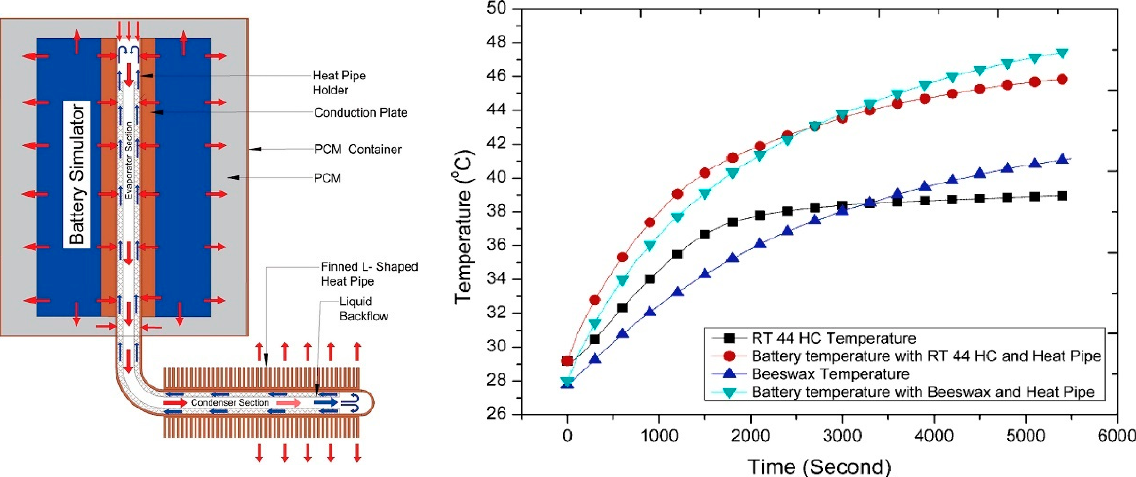
Figure 23. ( Left ): the BTMS described in [84]; ( Right ): Battery surface temperature for various BTMS investigated in [84] for heat dissipation rate 60 W. Hu et al. [85] developed a PCM-based BTMS using Eicosane and a flat heat pipe, presented in Figure 24.